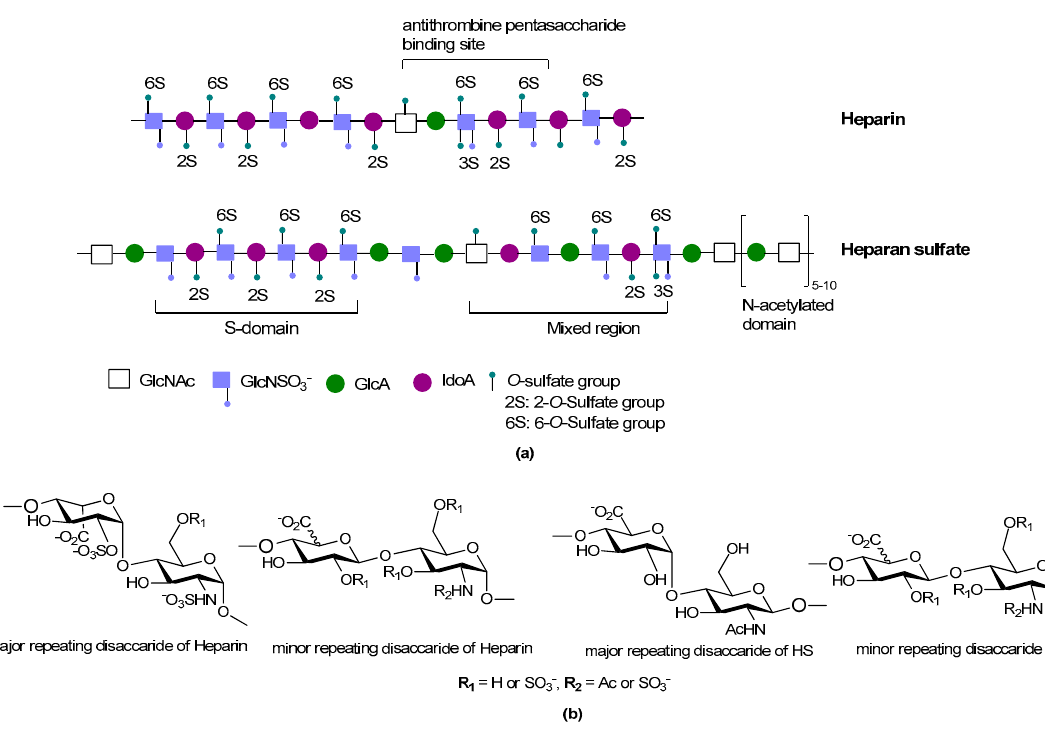
Figure 1. ( a ) Cartoon illustration of heparin and heparan sulfate structure; ( b ) Major and minor disaccharide repeating units in heparin and heparan sulfate.